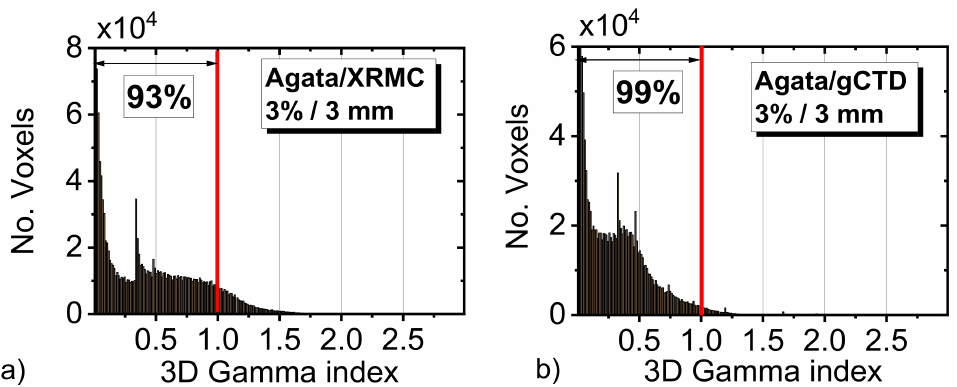
Figure 8. Distributions of the measured gamma indices in the comparison with the dose distribution that was simulated with the three different codes and different values for DTA and dose difference: ( a ) Agata (CPU) vs. XRMC (CPU), and ( b ) Agata (CPU) vs. gCTD (GPU). The vertical red line indicates the threshold value of 1 (93% and 99% for the two plots, respectively). Criteria considered for the 3D gamma index: 3%/3